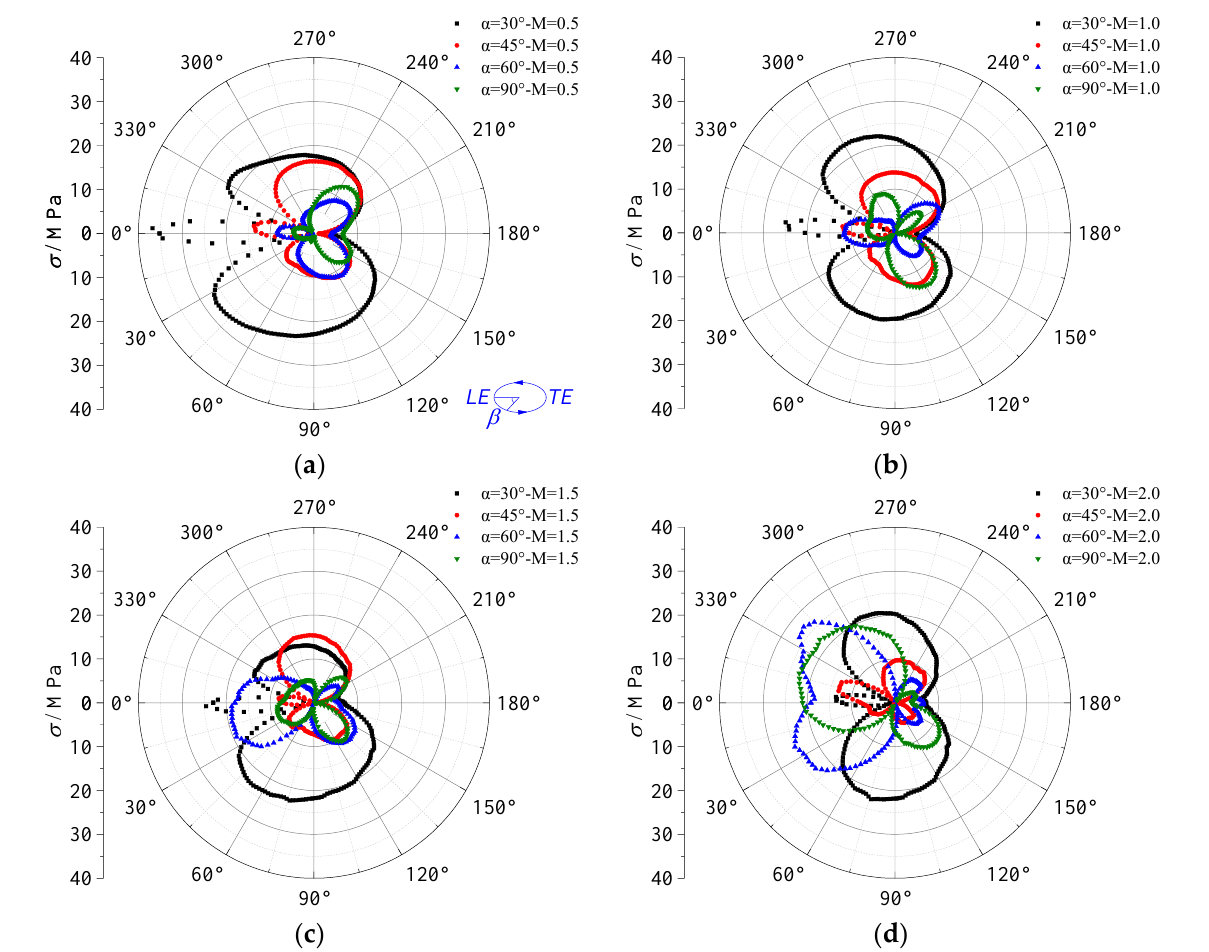
Figure 15. Thermal stress distributions around the research film hole’s exit for all cases. ( a ) M = 0.5. ( b ) M = 1.0. ( c ) M = 1.5. ( d ) M = 2.0.